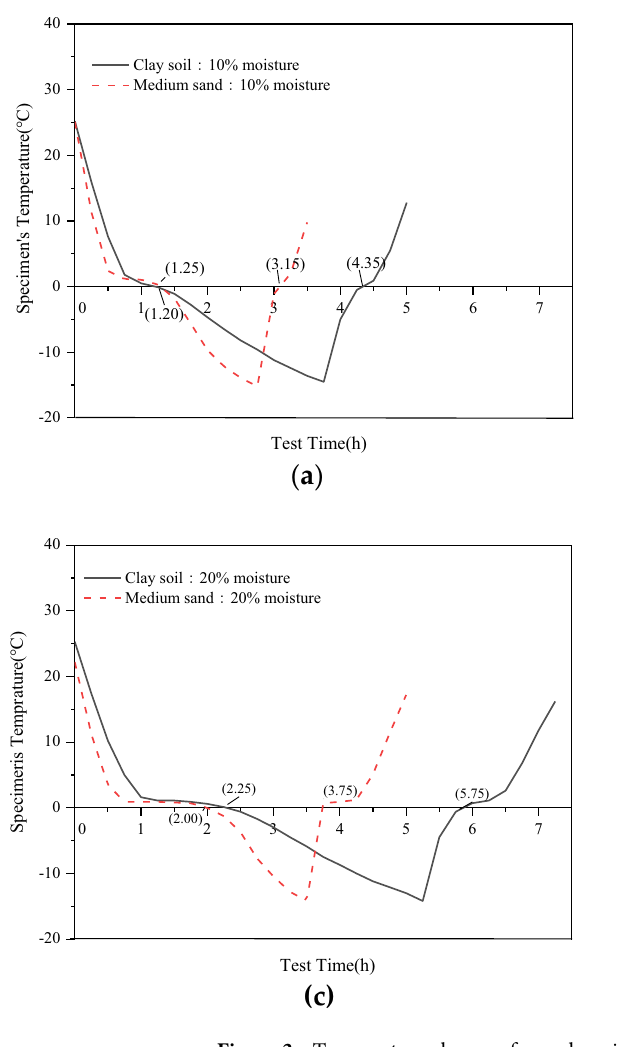
Figure 3. Temperature change of samples with the samebut different moisture content. ( a ) Two samples, each with a moisture content of 10%; ( b ) Two samples with a moisture content of 15%; ( c ) Two samples with a water content of 20% each.